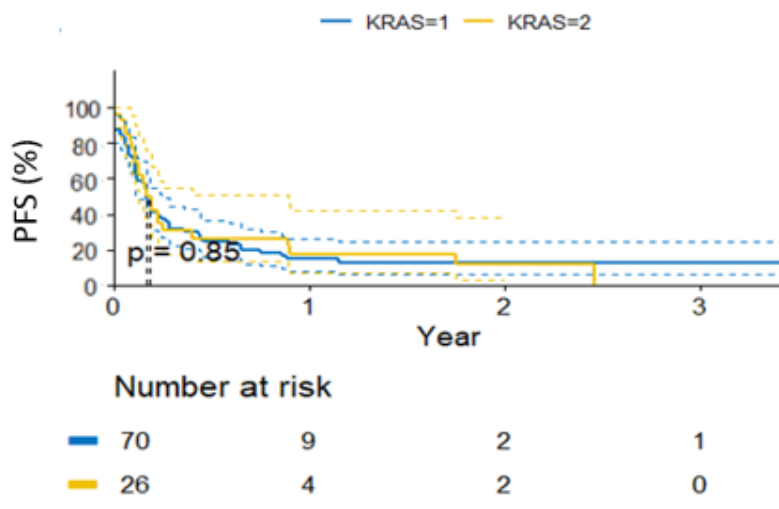
Figure 3. Progression-free survival probability in subgroups by KRAS